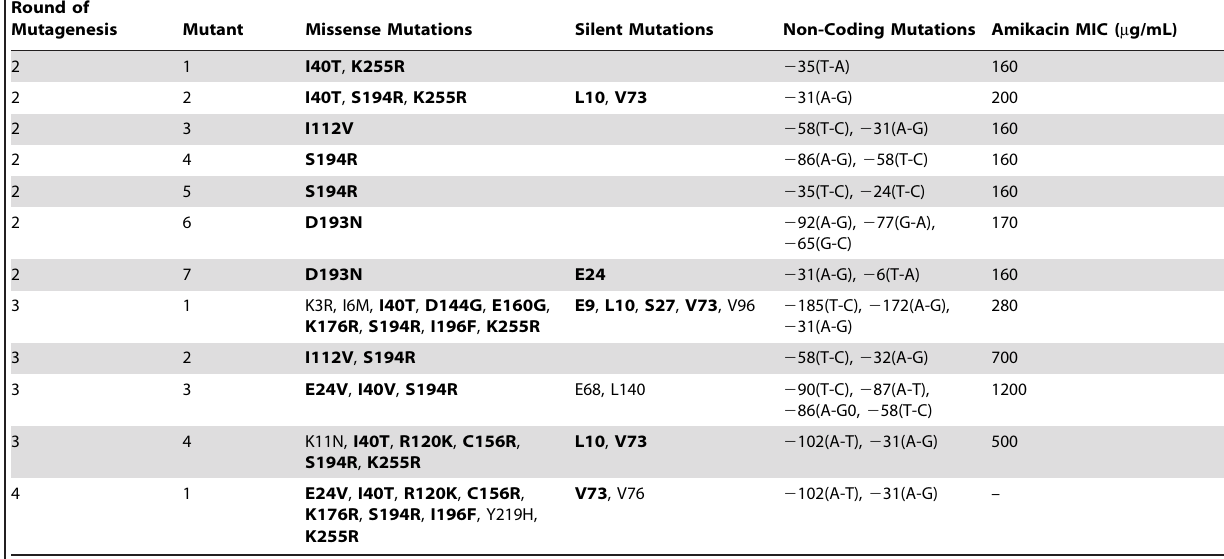
Round of Mutagenesis Mutant Missense Mutations Silent Mutations Non-Coding Mutations Amikacin MIC ( m